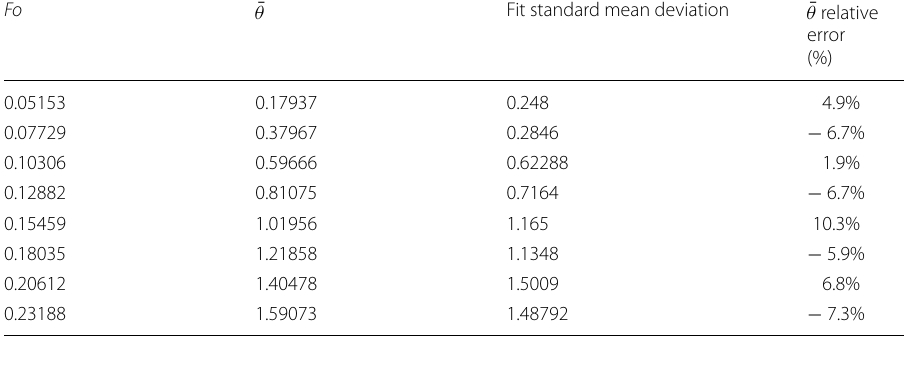
Table 4 Comparison between the numerical solutions and the Hecht-Méndez’s solution in: relative error for Fo Fo